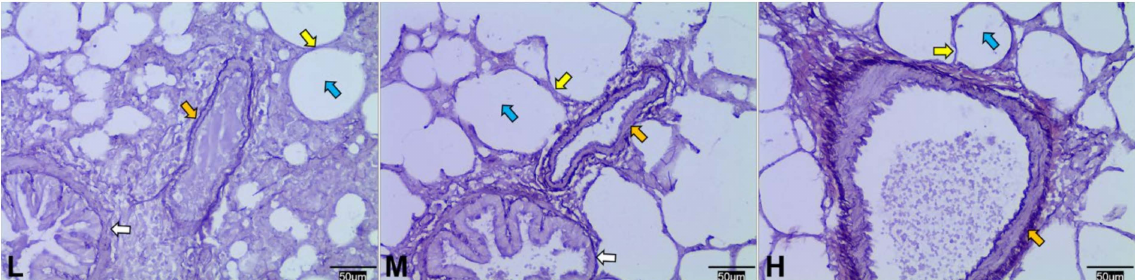
Figure 4. Weigert resorcinol magenta (WRM) staining of elastic fibers at low (L), middle (M), and high (H) altitudes under 400 × field of view. Yellow, blue, orange, and white arrows indicate alveolar septum, alveoli, blood vessels, and terminal bronchioles, respectively.